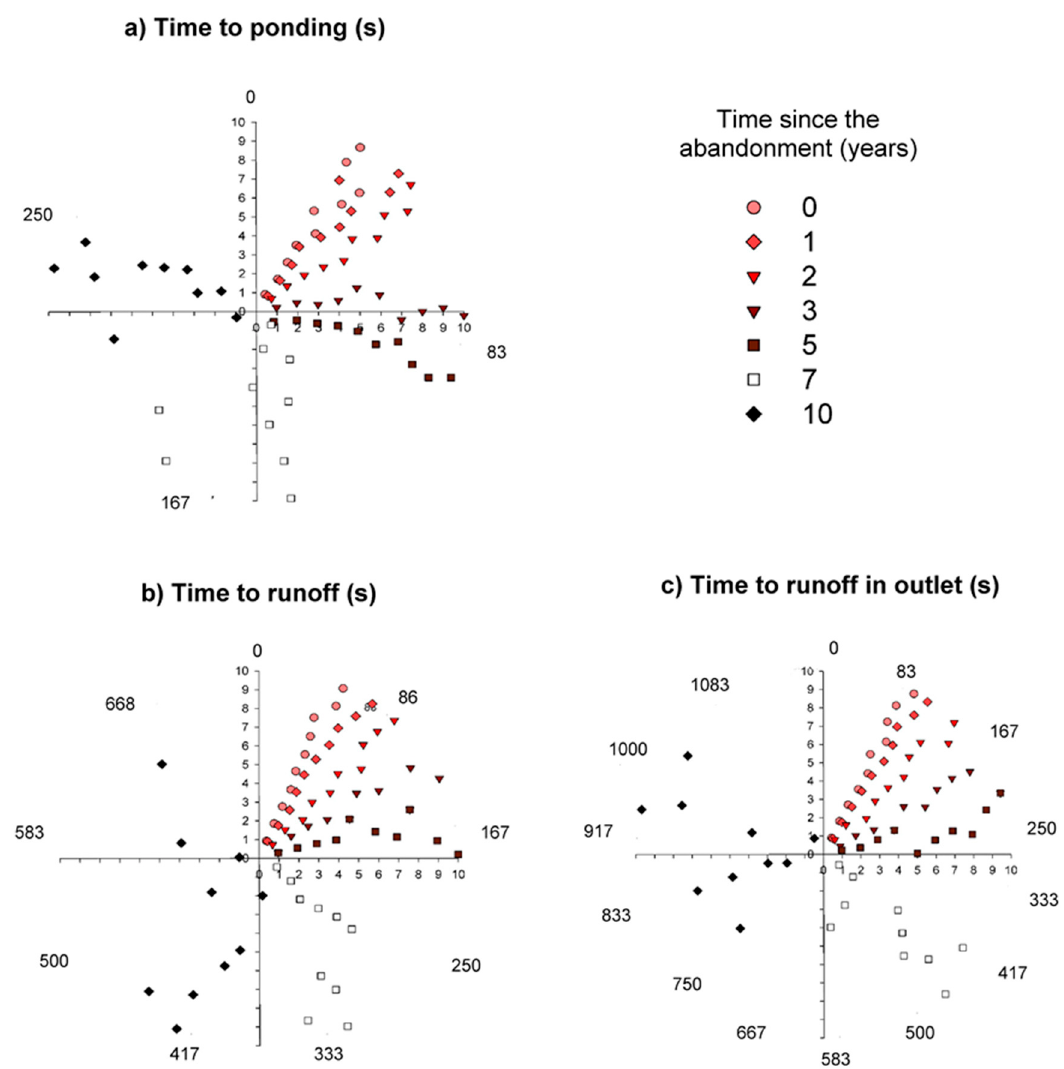
Figure 3. Hydrological response depending on the period of abandonment (360° = range of values).